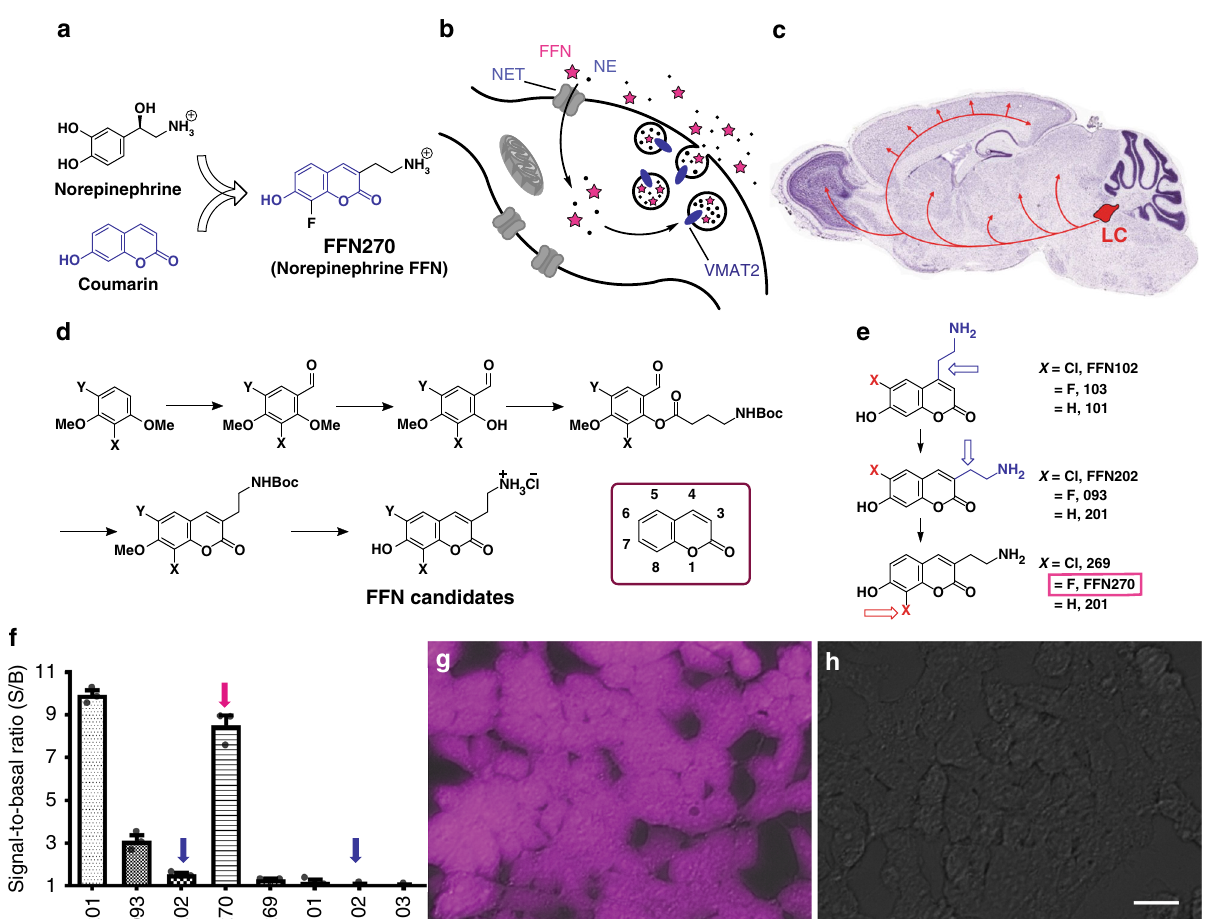
Fig. 1 Design of NE-FFNs. a The design of NE-FFNs combines structural features of NE with the coumarin fl uorescent core. b NE-FFNs trace NE uptake from the extracellular space, packaging into vesicles, and exocytosis as they are designed to be substrates of NET and VMAT2. c Representative illustration of NE neuron distribution in the brain (Allen Institute) 51 . Many NE neurons originate from the locus coeruleus (LC) and project to the majority of brain regions. d General synthetic scheme for preparation of 3-series aminoethyl-7-hydroxycoumarins as potential NE-FFN candidates. See Methods for experimental conditions. e Focused series of candidate NE-FFNs. f Total cellular fl uorescence after loading of FFN candidates (5 µ M) in hNET-HEK cells. Signal-to-Basal ratio (S/B ± SEM) was determined by comparing FFN fl uorescence in the presence and absence of 2 µ M nomifensine (NET inhibitor) after a 30 min incubation period. Blue arrows highlight previously described DA-FFNs, and a magenta arrow highlights FFN270, the leading pH-sensitive NE-FFN candidate (S/B: 8.5 ± 0.4, mean ± SEM, n = 3 independent experiments run in triplicate). Representative images of FFN270 without inhibitor ( g ) and with inhibitor ( h ). Scale bar: 20 µ